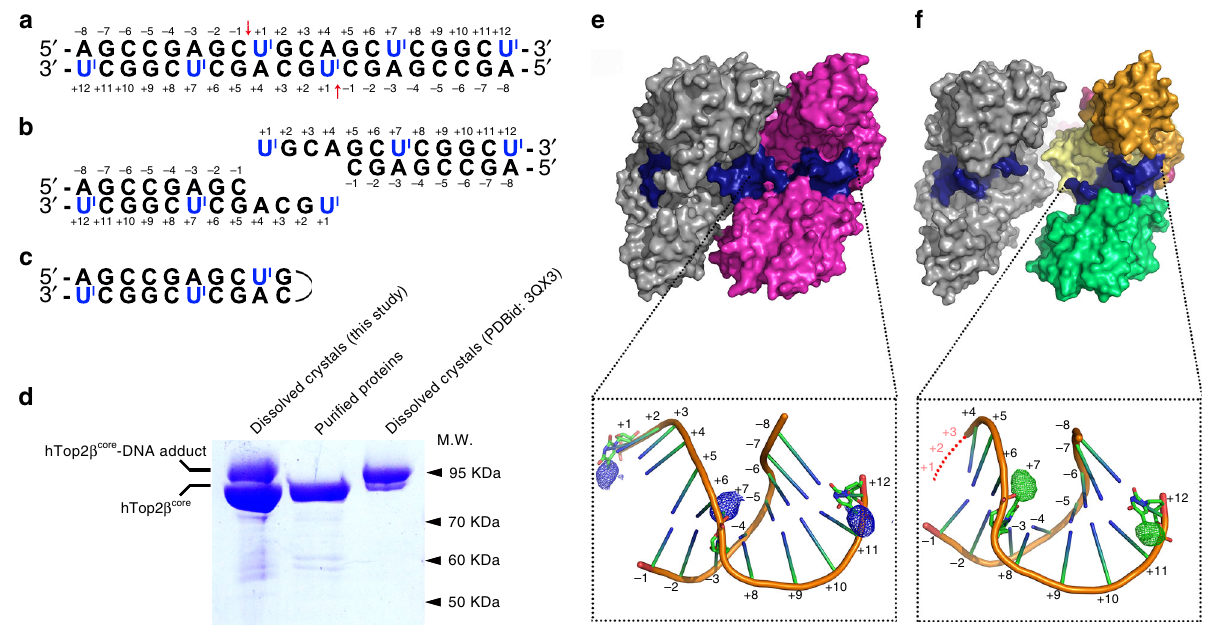
Fig. 2 The reported structure represents a bona fi de Top2 cleavage complex. a The sequence of iodine-labeled duplex DNA was derived from Fig. 1b by replacing thymidine nucleotides with 5-iododeoxyuridines (abbreviated as U I ). Red arrows indicate the anticipated cleavage sites. b The cleaved fragments expected from Top2-mediated cutting of the iodine-labeled duplex DNA. The 5-iododeoxyuridines (U I ) should be found at the + 1, + 7, and + 12 positions. c Due to the palindromic nature of the DNA sequence, the oligonucleotide might form a hairpin with the three iodine-labeled nucleotides located at positions distinct from those in b . d SDS-PAGE analysis of the dissolved hTop2 β core -DNA crystals. The presence of a species that migrates slower than the apo (DNA-free) Top2 but similar to the Top2-DNA adduct suggests that the newly obtained crystal is composed of the Top2 cleavage complex. The uncropped image has been provided as Supplementary Figure 10. e Surface representation of the etoposide-stabilized Top2 cleavage complex with a selected region of the bound DNA overlaid on the difference electron density map calculated by subtracting the native diffraction amplitudes from iododeoxyuridine- derivatized diffraction amplitudes ( F iododeoxyuridine – F native ) and phased with native phases (blue mesh, contoured at 4.0 σ ). Difference peaks corresponding to the iodine sites can be found at the expected positions (C5 positions of the + 1, + 7, and + 12 nucleotides). f Surface representation of the newly determined hTop2 β core -DNA binary complex structure with a selected region of the bound DNA overlaid on the difference electron density map calculated by subtracting the native diffraction amplitudes from iododeoxyuridine-derivatized diffraction amplitudes ( F iododeoxyuridine – F native ) and phased with native phases (green mesh, contoured at 4.0 σ ). Difference peaks corresponding to the iodine sites were found at the + 7 and + 12 nucleotides, indicating that the observed DNA fragment was produced by Top2-mediated cleavage, as shown in b . The lack of a difference peak at the + 1 position provides strong support that the + 1 ~ + 3 nucleotides of the cohesive ends (red dashed line) are completely disordered in this